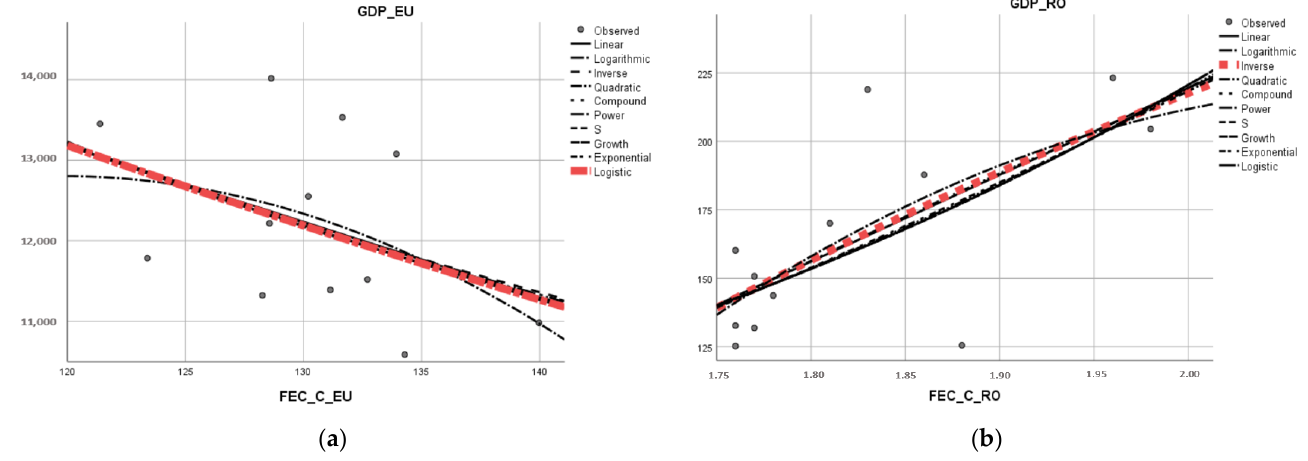
Figure 11. MLP network for identifying the influences of FEC_C on GDP: ( a ) EU; ( b ) RO.